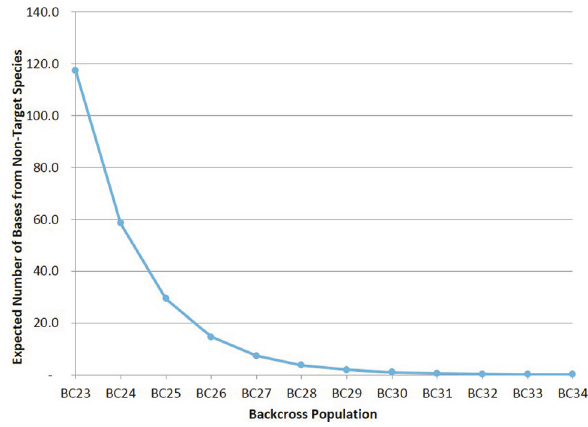
Figure 2 - Expected number of base-pairs (E) from a non-target species, considering number of backcross generation with a target species with a genome of